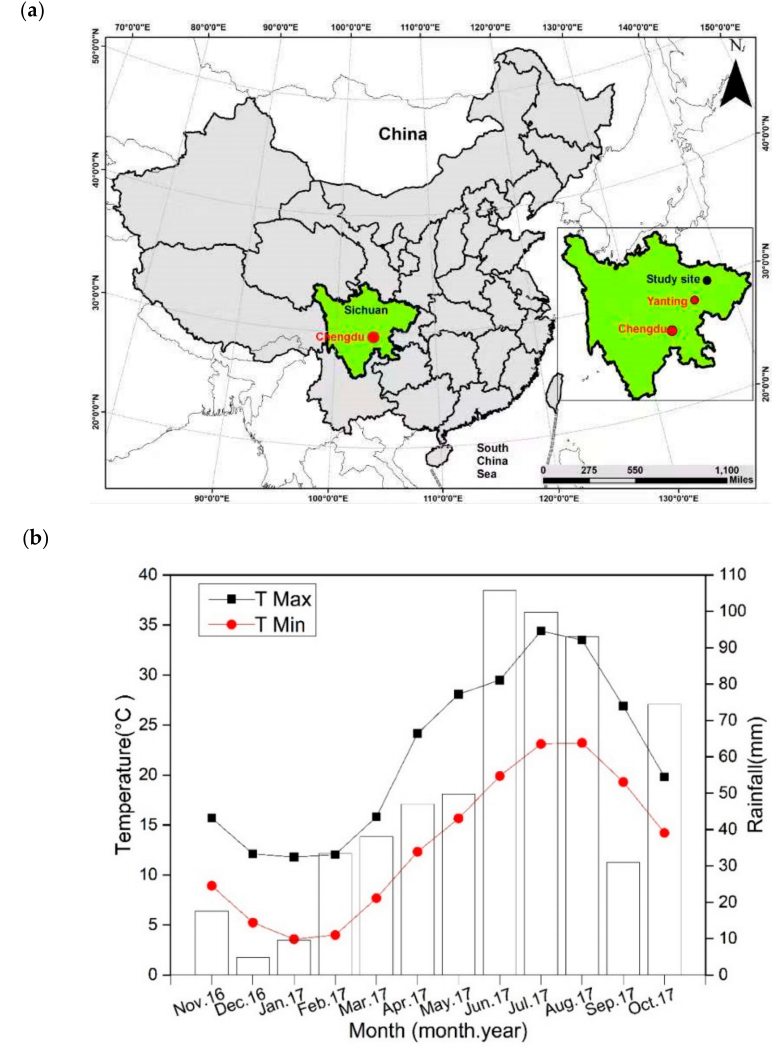
Figure 1. ( a ) Location of the study site, ( b ) climatic conditions during the preparation of